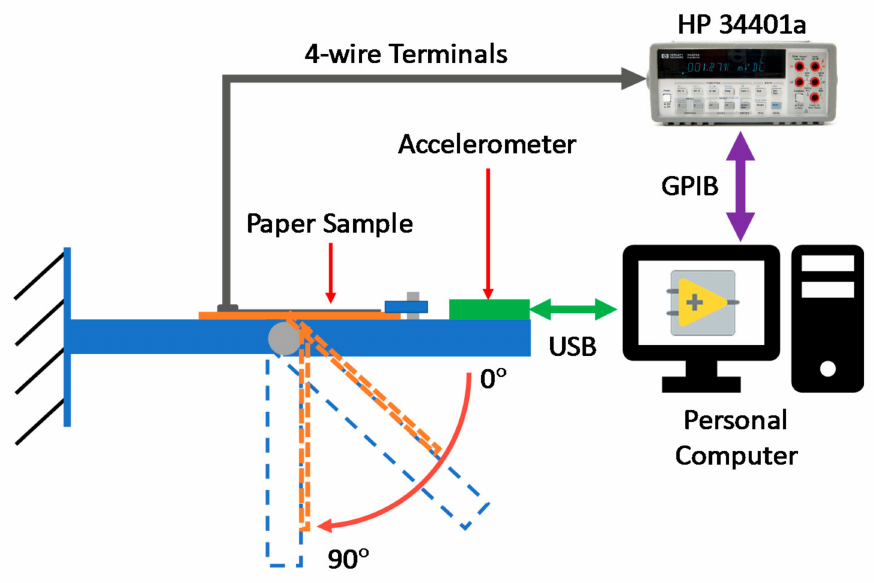
Figure 8. Schematic representation of the bending